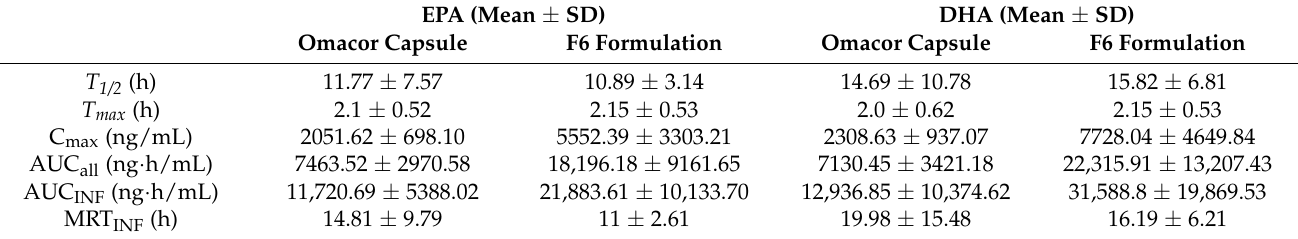
Table 4. Plasma concentration of the SALCs (F6) and reference (Omacor) after oral administration with a single dose of 1000 mg/head. Each value represents arithmetic mean ± SD ( n = 5).